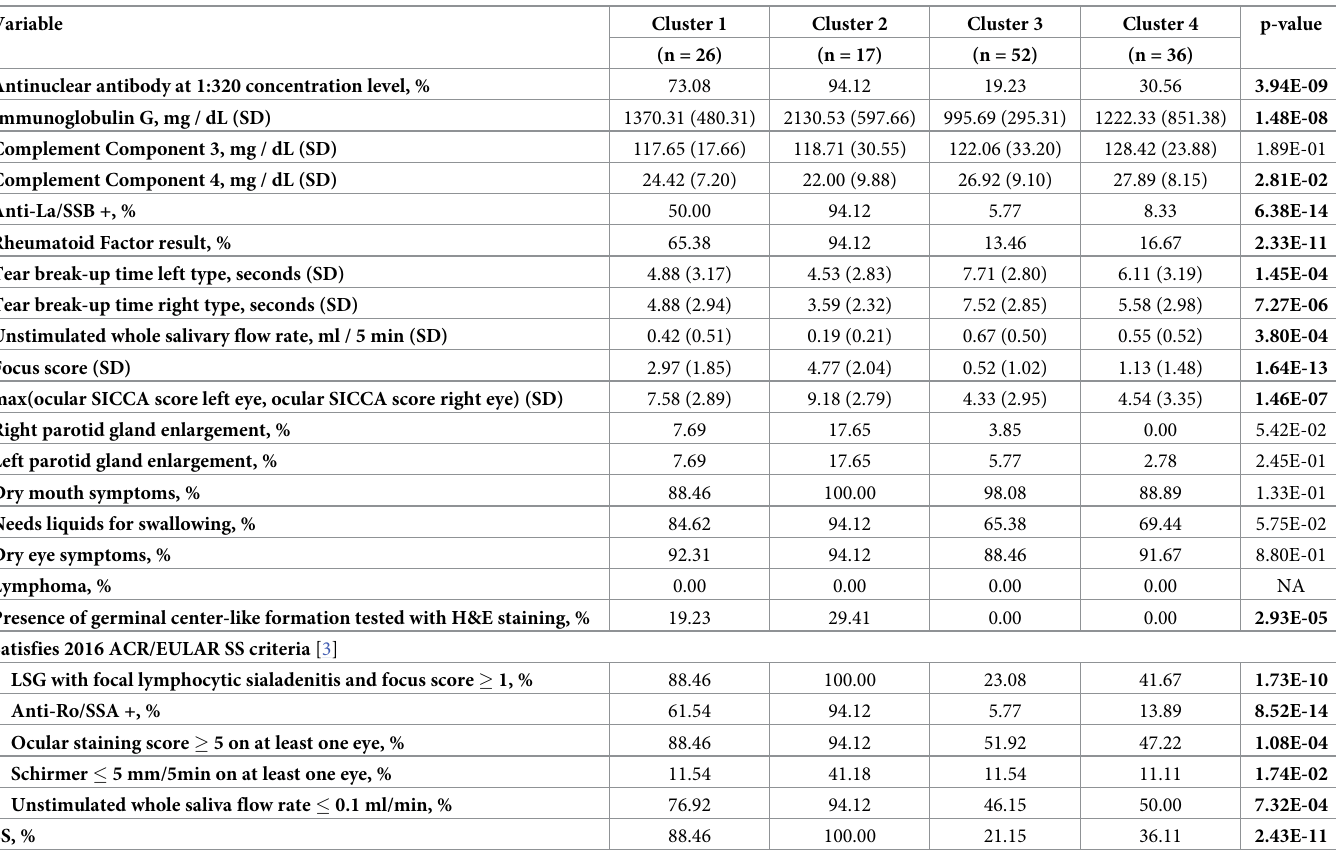
Table 1. Clinical phenotype analysis by cluster.